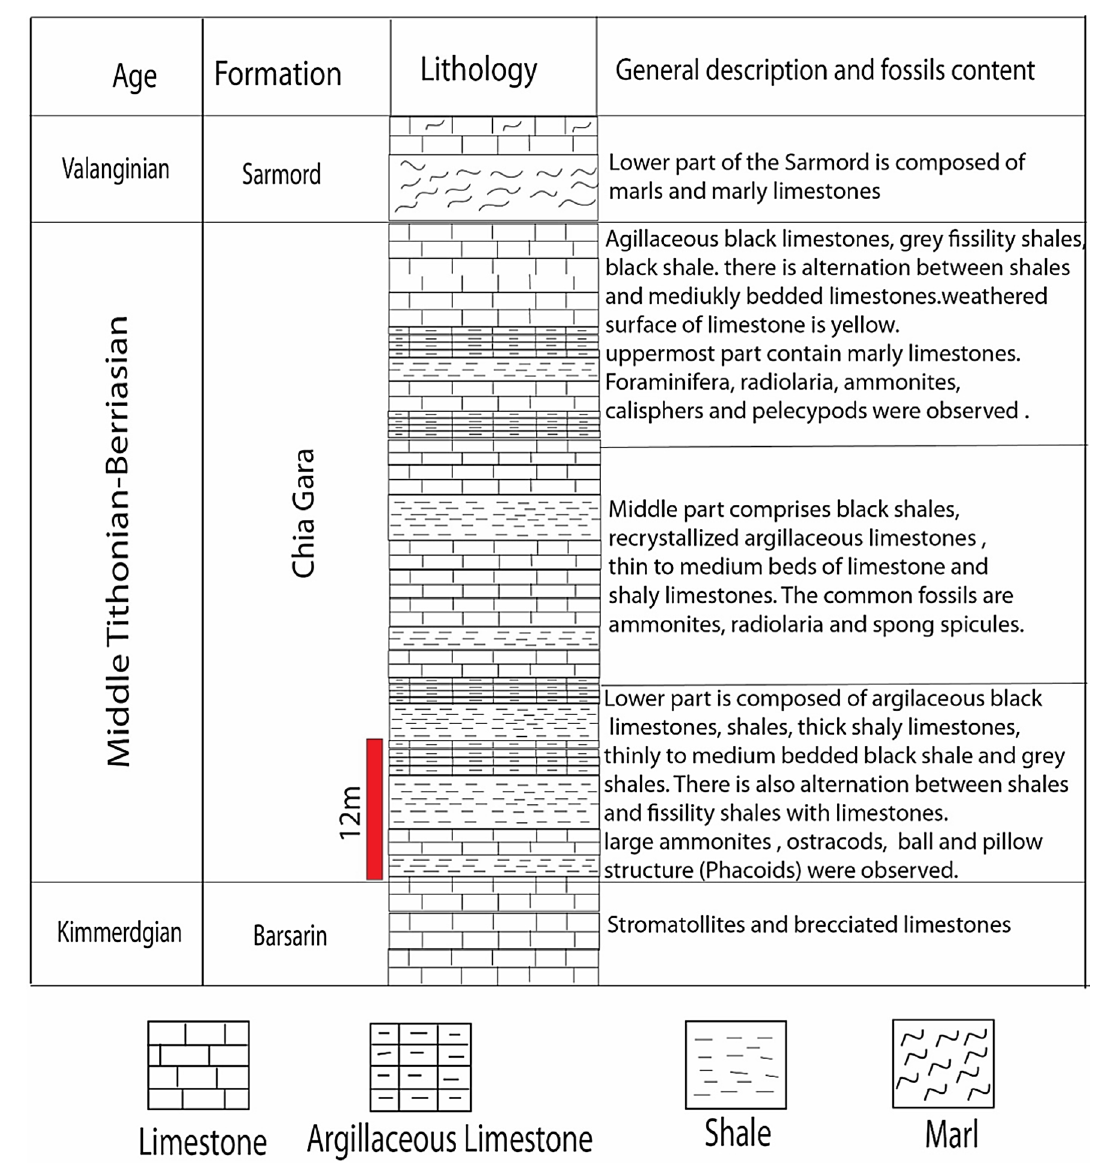
Fig. 4 Stratigraphic column of Chia Gara Formation in Banik Section, Duhok, Kurdistan